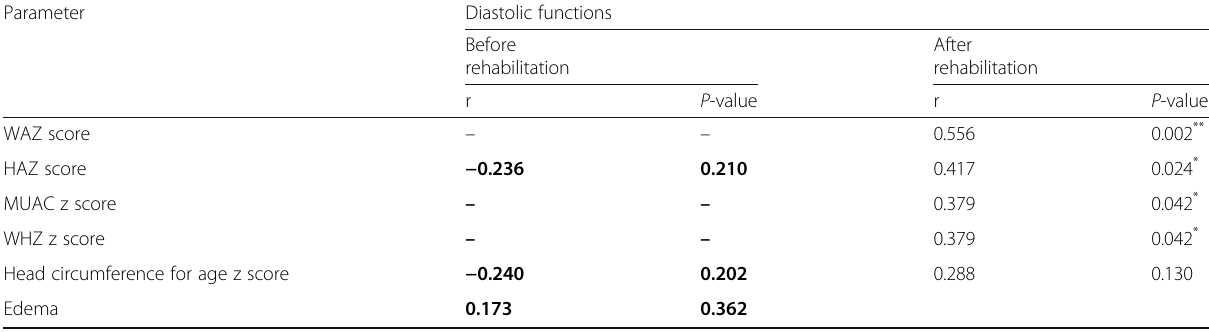
Table 4 Correlation between diastolic function by TDI and anthropometric measurements of the studied children with SAM before and after nutritional rehabilitation